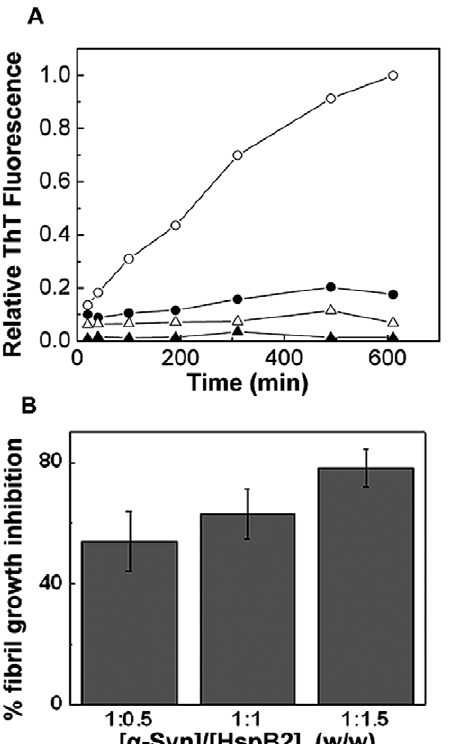
Figure 9. Prevention of a -synuclein amyloid fibril formation by HspB2. (a) Amyloid fibril formation of a -synuclein in the absence (- # -) and in the presence of HspB2 at a -synuclein to HspB2 ratio of 1:1.5 (- monitored by ThT fluorescence. HspB2 incubated with a -synuclein seeds (- m -), or HspB2 alone (- D -) showed negligible ThT fluorescence. (b) Percentage prevention of a -synuclein amyloid fibril growth in the presence of various concentrations of HspB2. Error bars for 7 sets of experimental data are